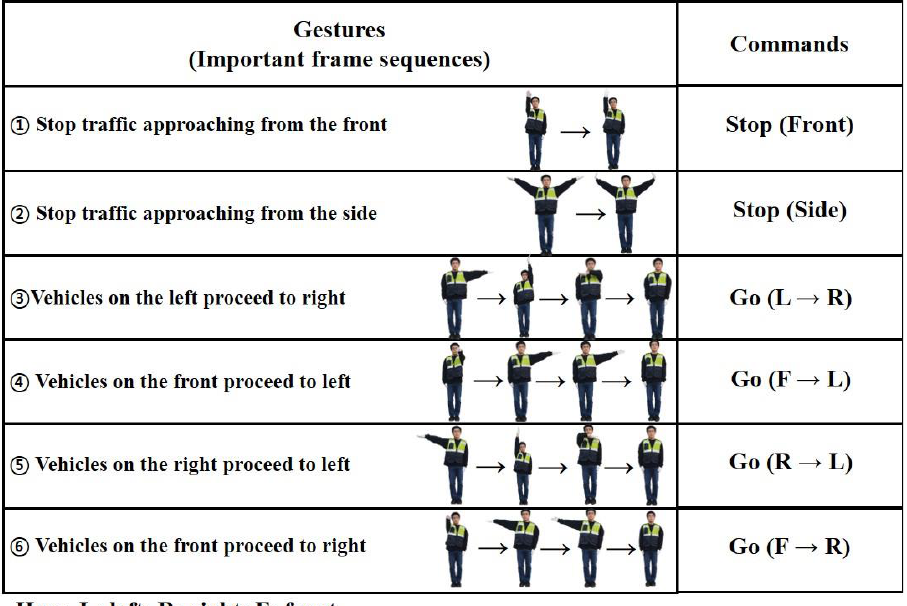
Figure 4. Traffic control hand gestures. These are a combination of commonly used traffic control gestures in different countries.